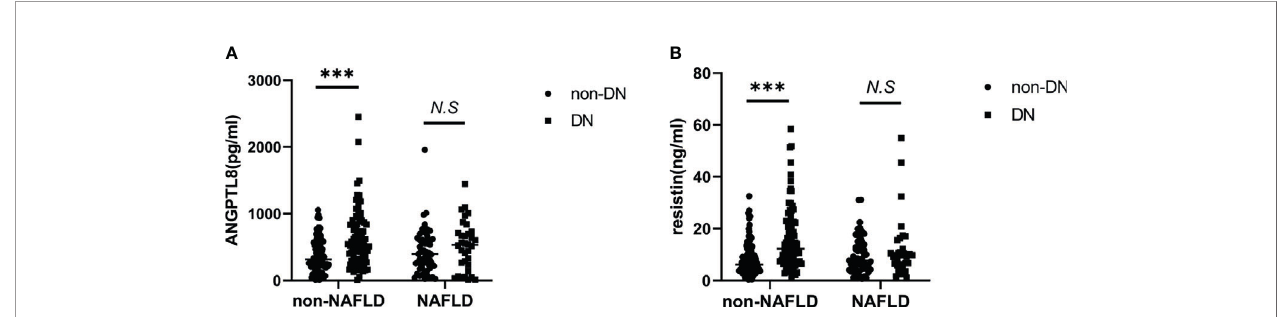
FIGURE 3 | T2DM patients with DN had higher levels of ANGPTL8 and resistin In non-NAFLD population. (A) , ANGPTL8 levels were elevated in non-NAFLD population. (B) , Resistin levels were elevated in non-NAFLD population. ***p < 0.001 vs. NAFLD group. NS, non signi fi